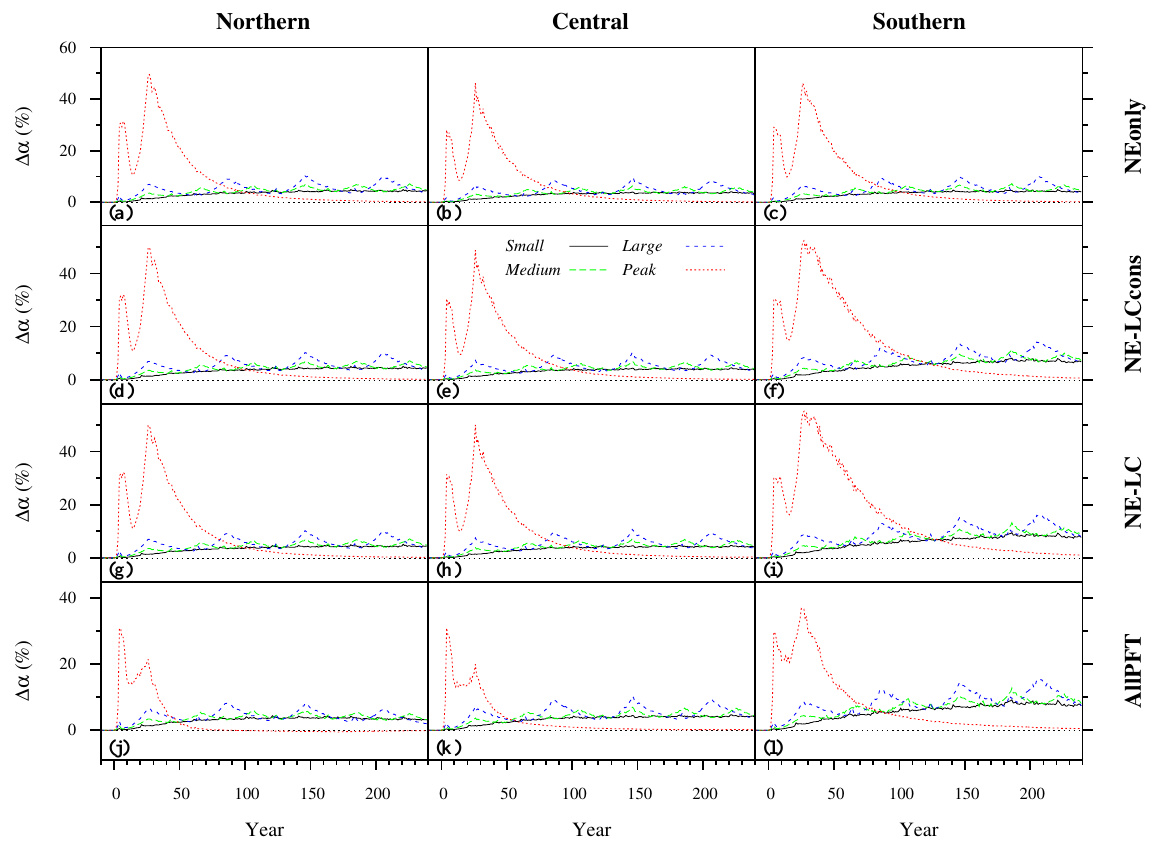
Figure 4. Transient effect of the different MPB outbreak regimes on surface albedo ( α ) compared with the no-outbreak control run (first outbreak occurred in year 1). The columns correspond to the three locations (Fig. 1) and the rows to the four vegetation coexistence scenarios (Table 2). Control values differed among locations and vegetation coexistence scenarios, so the same relative change (in %) across the 12 panels does not correspond to the same absolute